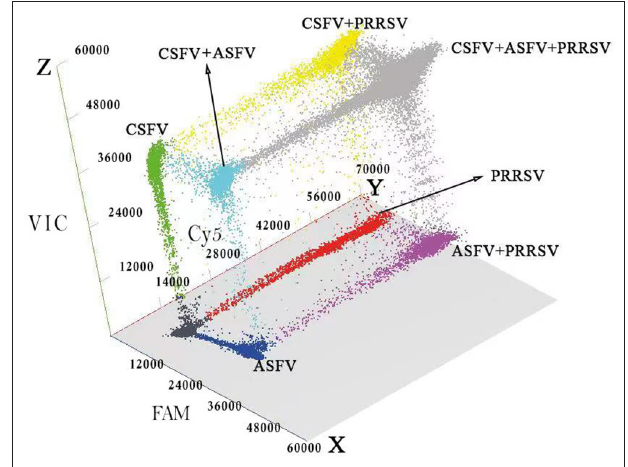
FIGURE 5 | Detection results of the clinical samples. The 3D scatterplots of fluorescence intensities were acquired in the Blue (x axis), Red (y axis) and Green (z axis) acquisition